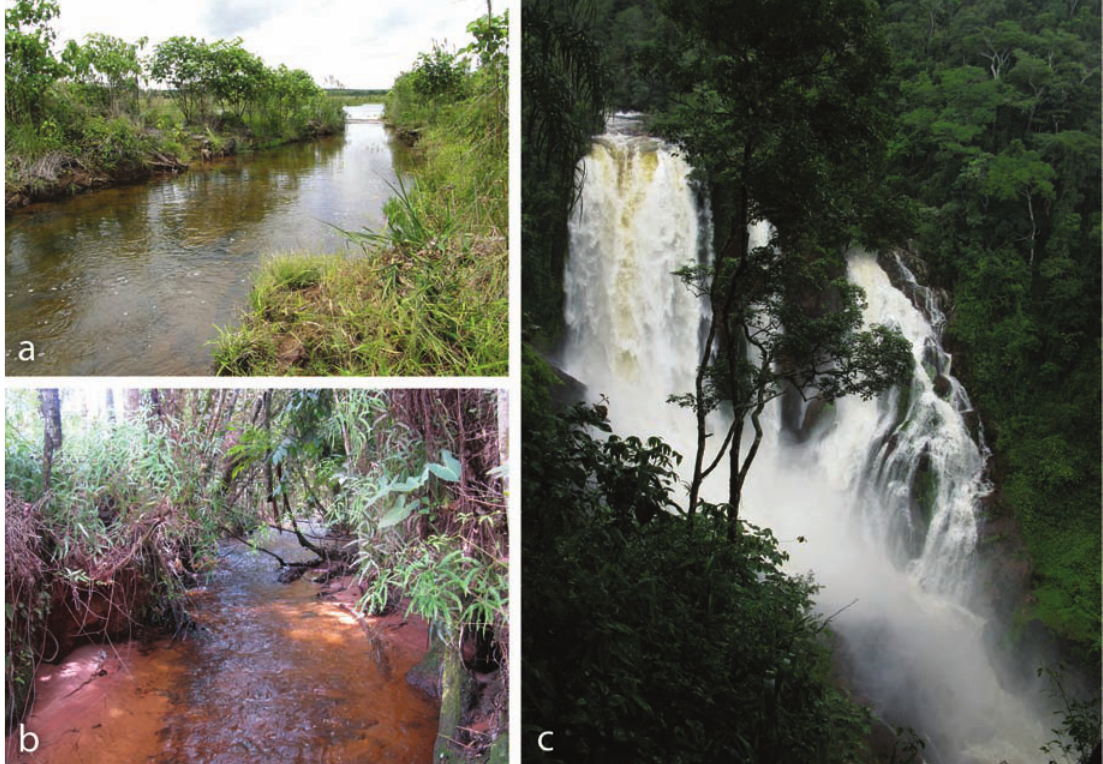
Fig. 5. Habitats at Serra do Cachimbo: a - type-locality of Moenkhausia chlorophthalma , rio Treze de Maio, tributary of